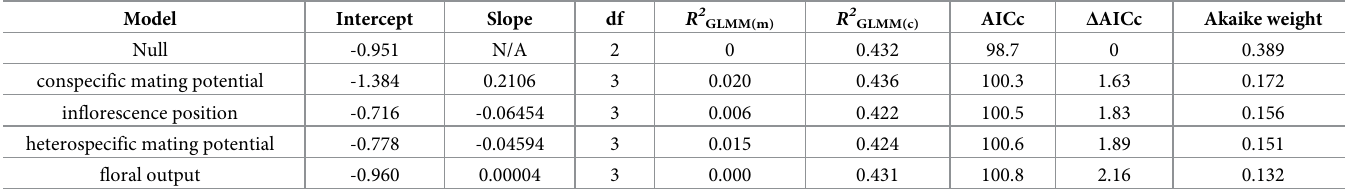
Table 5. Summary of model selection results for fruit set in C . scandens .